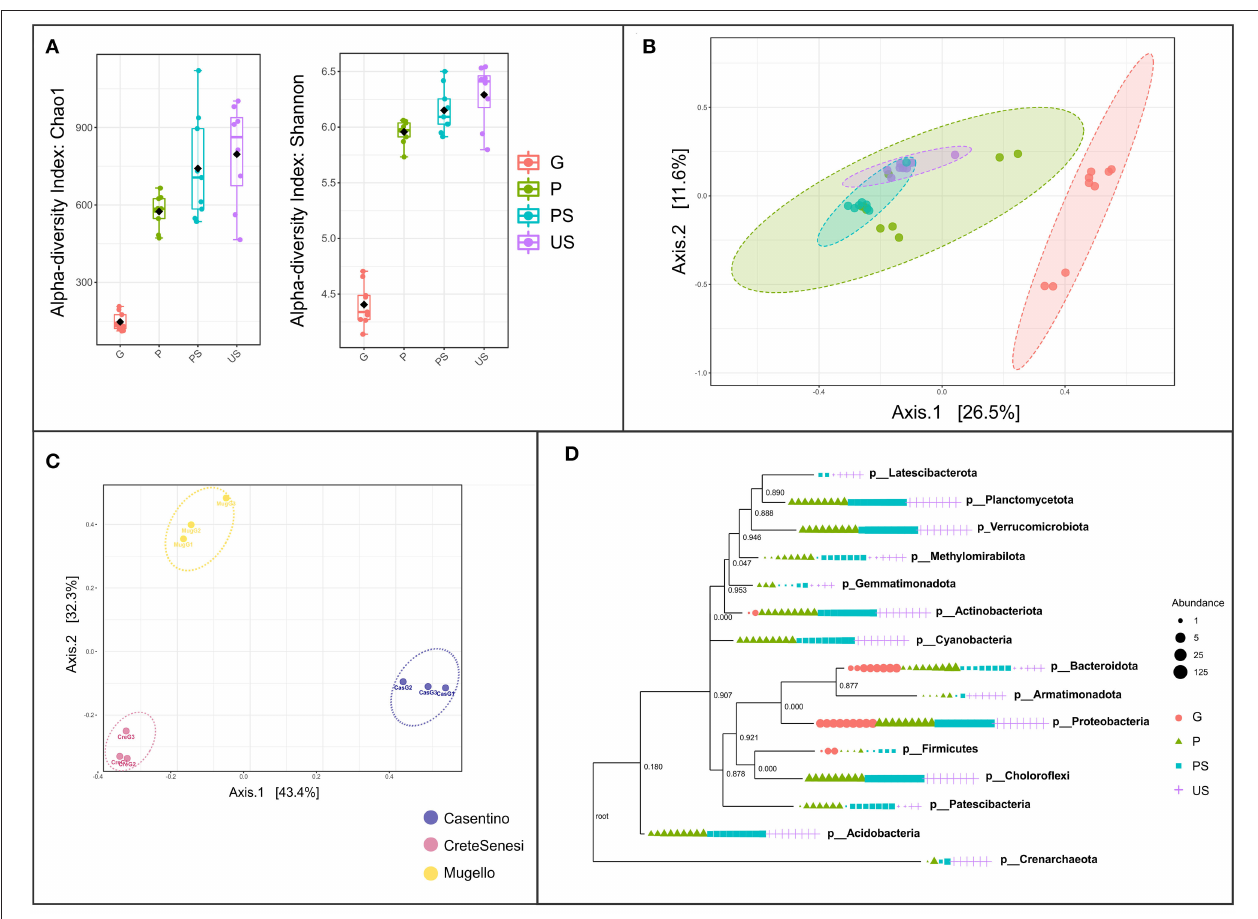
FIGURE 3 | Assessment of the microbial diversity within and between samples. (A) Alpha-diversity based on Shannon and Chao1 indexes, at feature level; (B) beta-diversity based on Bray-Curtis index, at the feature level. Red, green, cyan, and purple dots represent G, P, PS, and US samples, respectively; (C) beta-diversity based on weighted UniFrac distance at feature level on G (gleba) samples only; (D) phylogenetic tree (maximum-likelihood tree via raxml). Samples are grouped according to collection site (Cas, casentino; Cre, crete senesi; Mug, mugello) then to the truffle sample type (P, peridium; G, gleba) or the soil sample type (PS, productive soils; US, unproductive